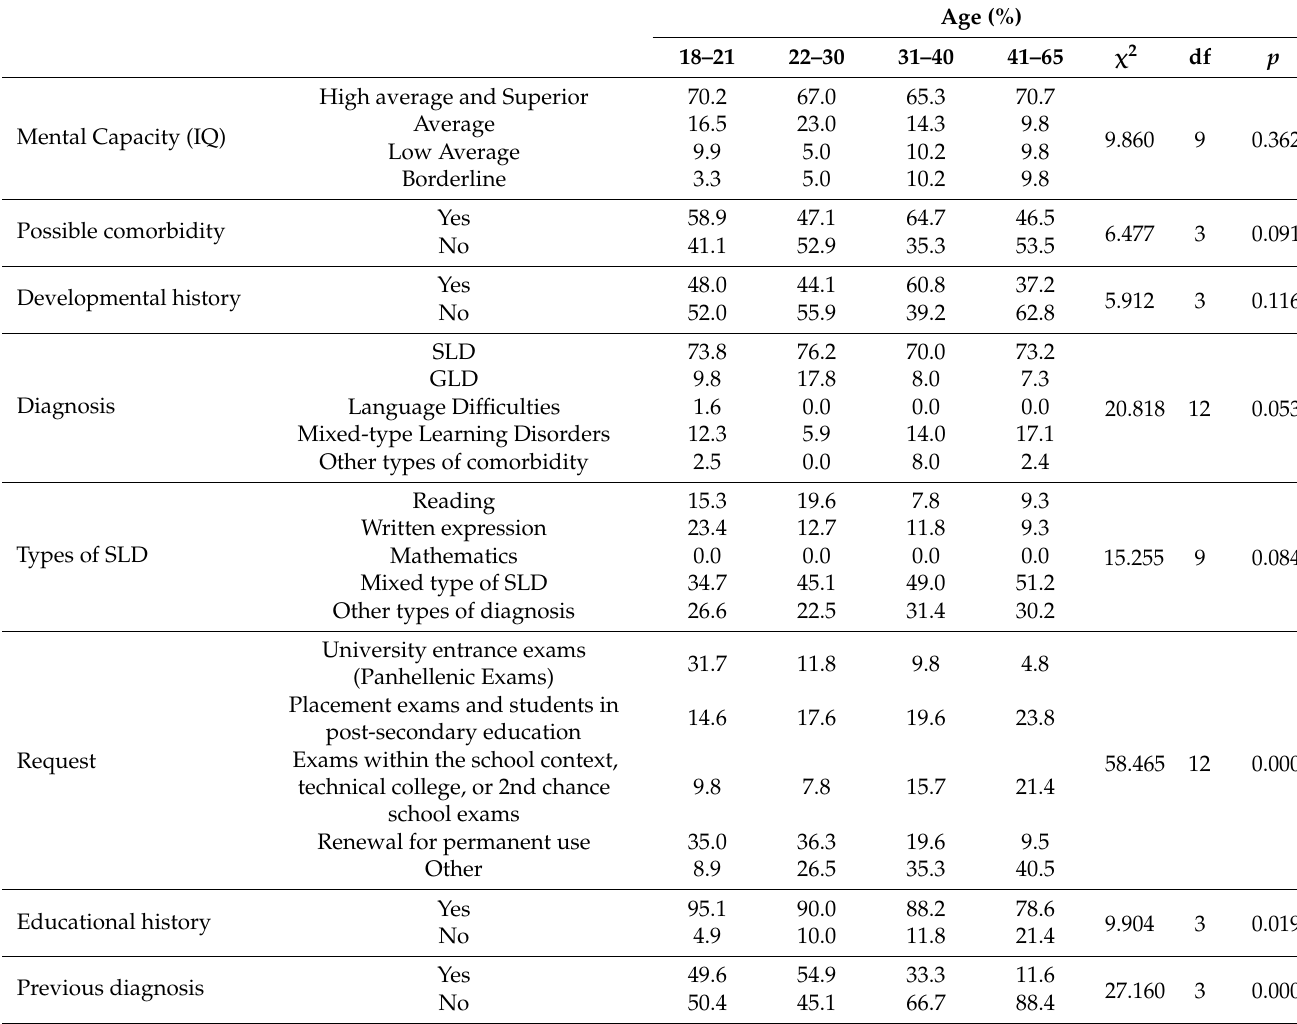
Table A12. Relationship of the Age of the assessed adults with the other variables.